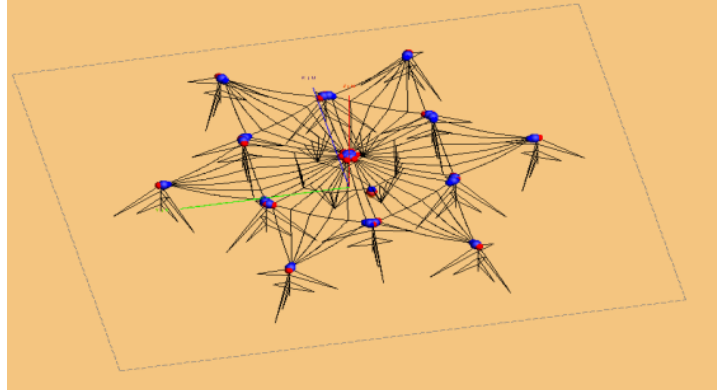
Figure 4. Model diagram of VLF umbrella-type transmitting